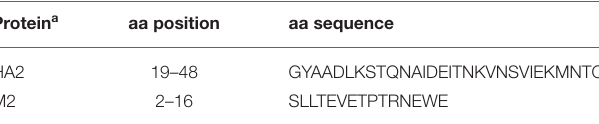
TABLE 3 | Peptides used for